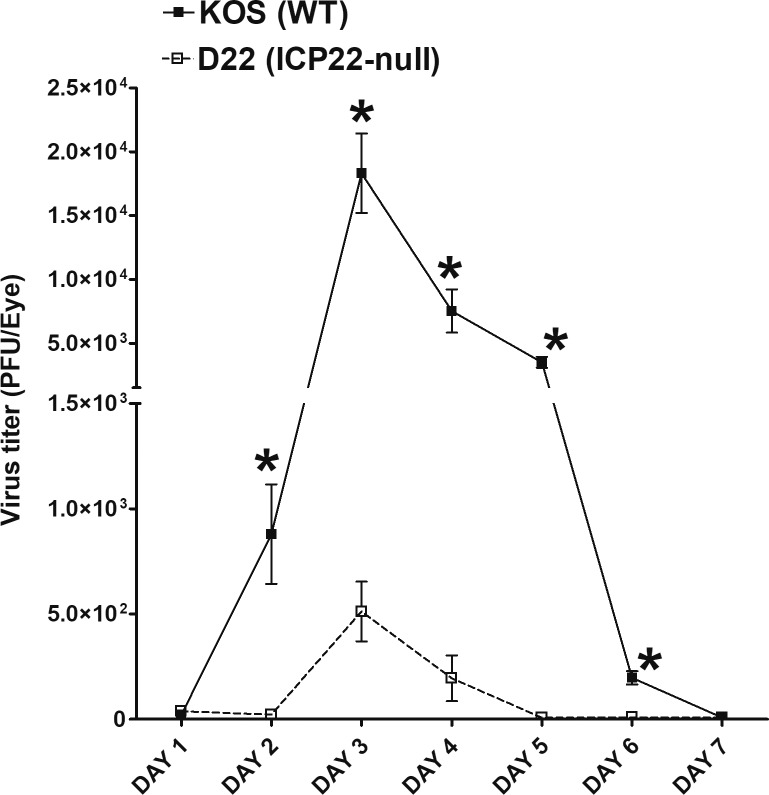
Viral titers in BALB/c mouse eyes following ocular infection with KOS strain of HSV-1 and D22 (ICP22 mutant) transgenic HSV-1 virus. Corneas from WT mice were scarified before ocular infection. They were then infected ocularly with 2 × 105 PFU per eye of KOS or ICP22 null virus. The presence of infectious virus in the eyes of mice was monitored daily for 7 days by collecting tear films and quantifying virus, using standard plaque assays as described (see Materials and Methods). Each bar represents the mean ± SEM from 40 eyes for KOS-infected mice, and 40 eyes for ICP22 null–infected mice.